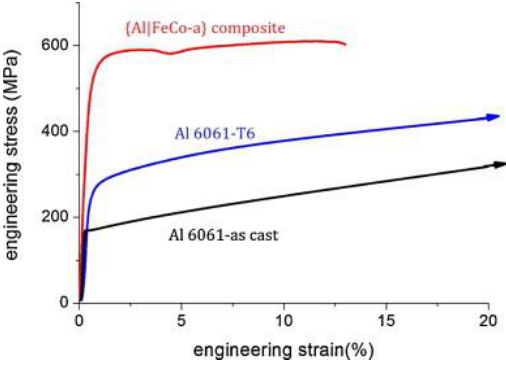
Figure 8. ( a ) DSC thermograms and ( b ) X ray diffractograms of Al matrix composite reinforced with Fe-based metallic glass compared to Al 6061 alloy and the Fe-based metallic glass powder (reprinted from Aljerf et al . 2012 [14], with permission from © Elsevier).